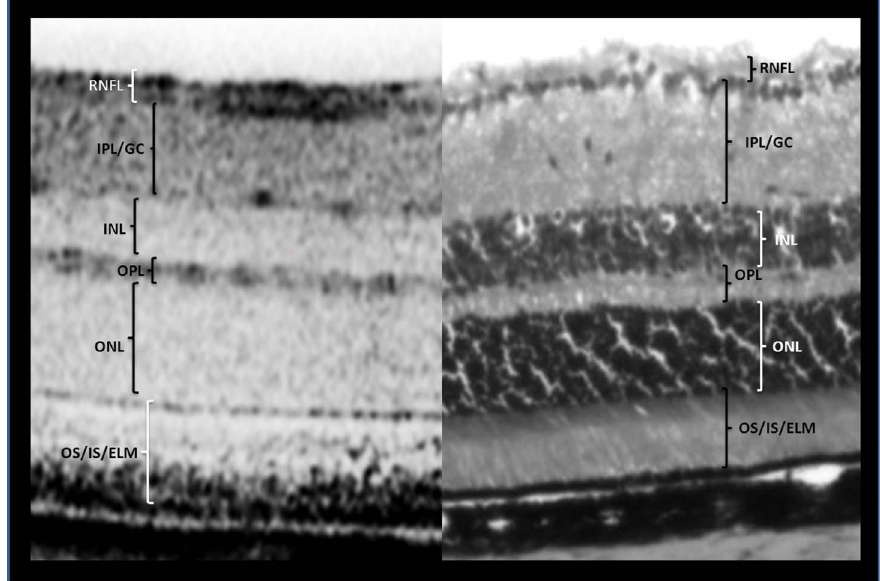
Figure 2. Cross-sectional views of the C57BL/6 mouse retina by SD-OCT (left) and histology (right). OS/IS/ELM, outer segment/inner segment/external limiting membrane; ONL, outer nuclear layer; OPL, outer plexiform layer; INL, inner nuclear layer; IPL/GC, inner plexiform layer/ ganglion cell; RNFL, retinal nerve fiber layer.